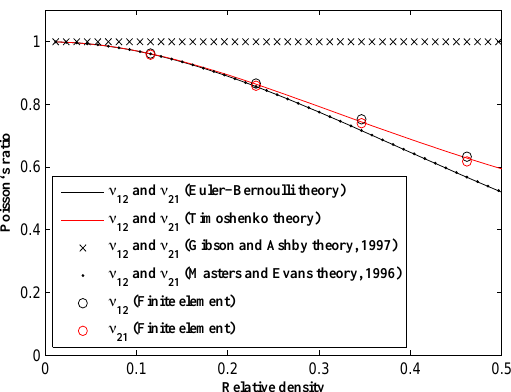
Figure 12. Comparison of analytical and numerical values of Poisson’s ratio for different relative densities.